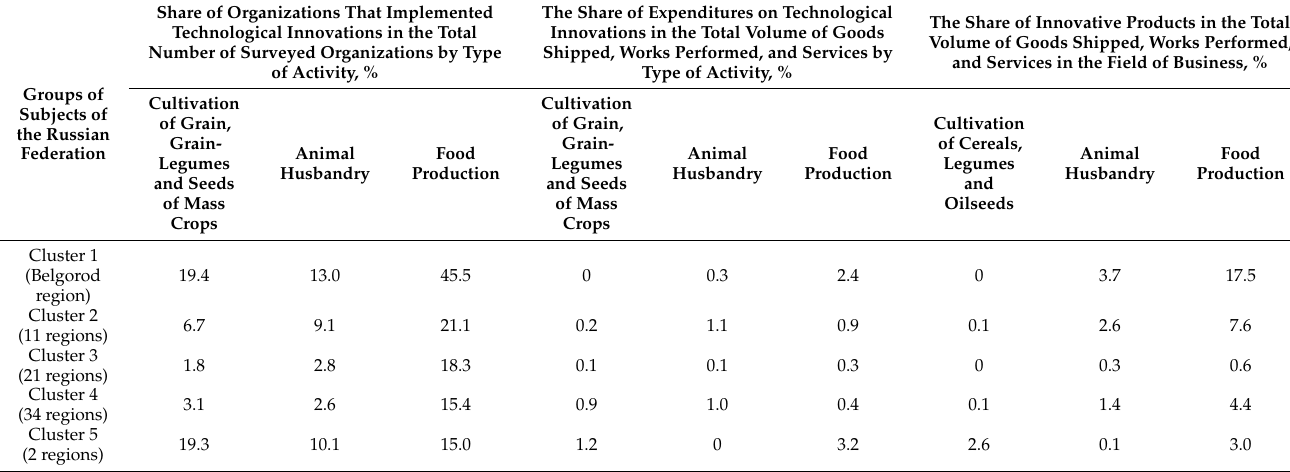
Table 5. Characteristics of clusters by the level of innovation activity of organizations and the innovative component of exports